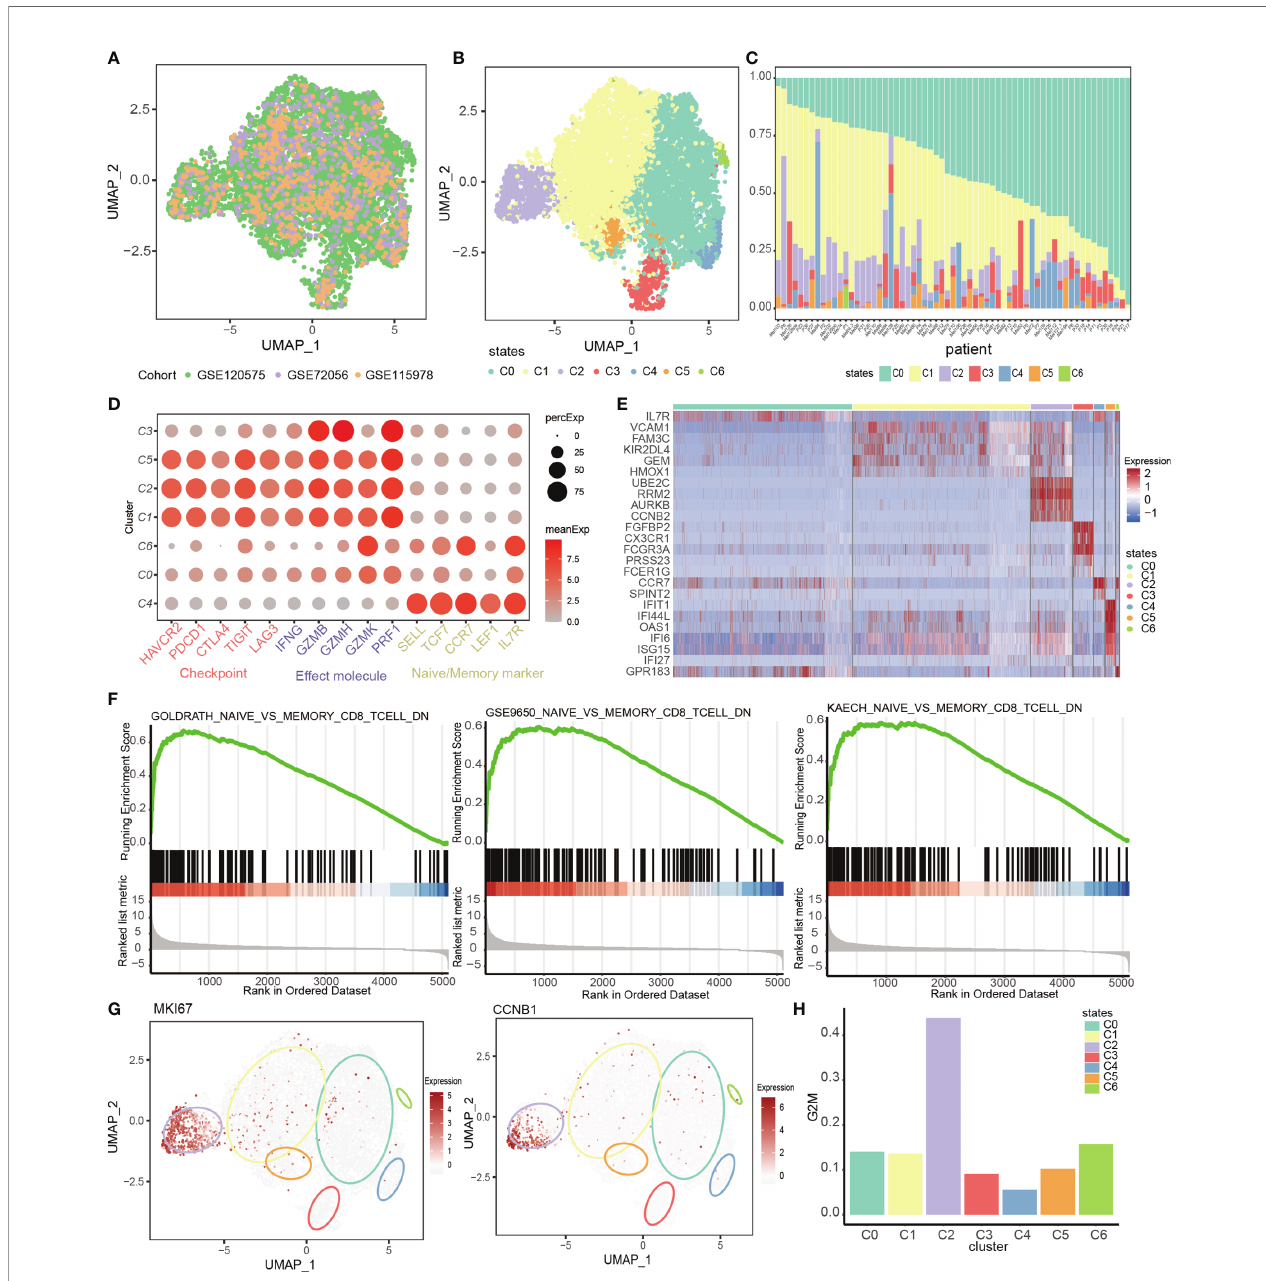
FIGURE 1 | The T cell landscape of melanoma reveals transcriptionally heterogeneous cell states. (A, B) UMAP plots of CCA-integrated pro fi les of all CD8+ T cells used in this study colored by datasets (A) and by cell states (B) . (C) The composition of T cell states in each patient. (D) Dot plot showing distribution of checkpoints, effect molecules and naïve markers in each T cell state. Color denotes the average expression of each gene in each cluster. Circle size denotes the percentage of cells that expresses the gene within the indicated cluster. (E) Heatmap showing expression levels of differential genes in each cell state. (F) GSEA plot showing enrichment of the gene sets upregulated in memory CD8+ T cells in the cluster C0_memory T cells when compared to C4_naive T cells. (G) UMAP feature plot representation of cell cycle markers (MKI67, CCNB1) within individual T cell state. (H) The proportion of proliferative cells in each T cell